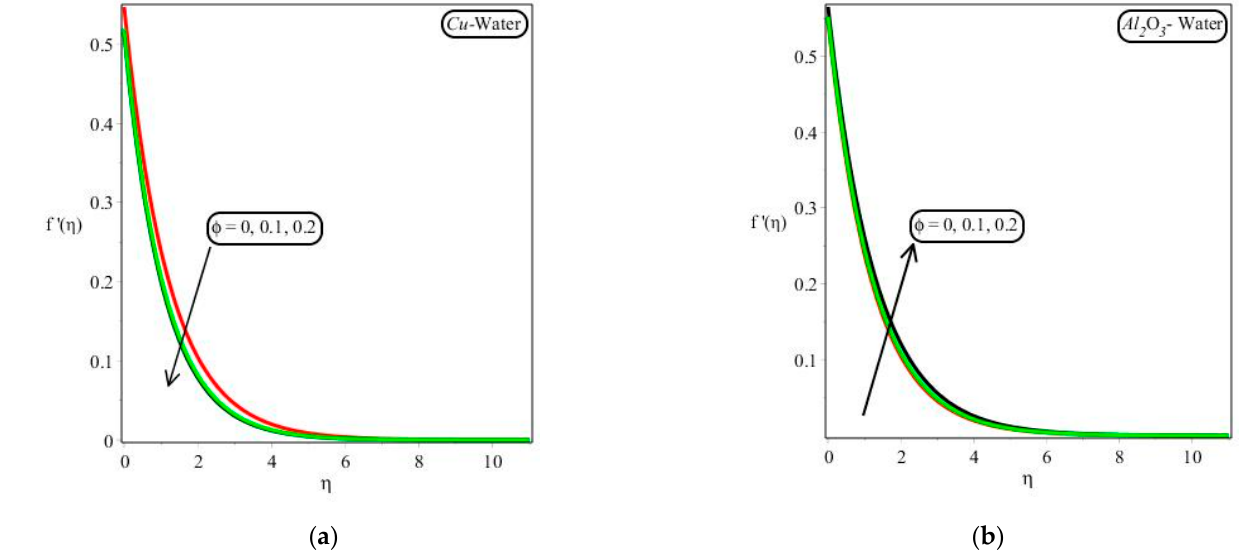
Figure 3. ( a , b ) Impact of φ on velocity profile with β = 1, γ = π /3, K 1 = 0.7, and M = 0.2.